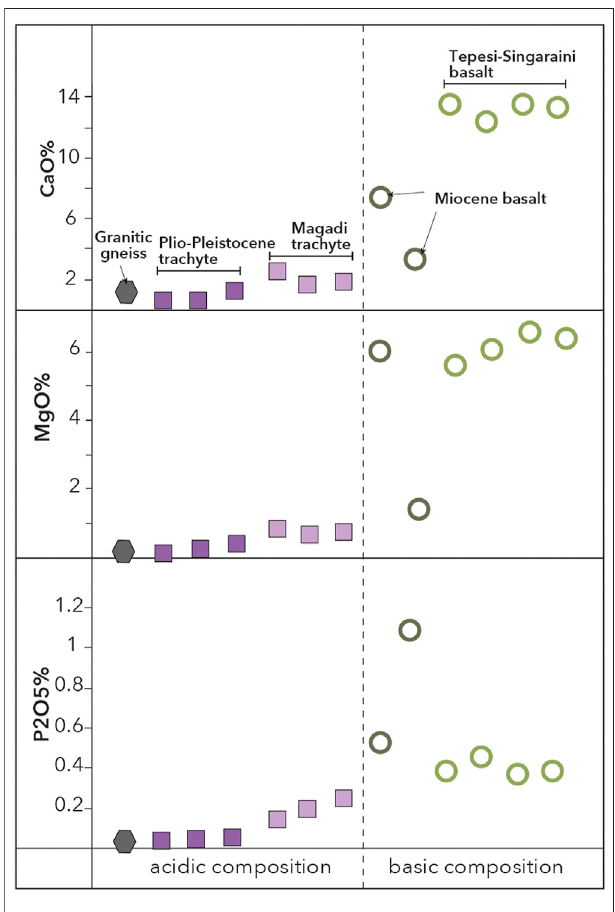
FIGURE 2 | Results of XRF whole rock analysis of the representative samples comprising basaltic, trachytic and subordinate granitic lithologies. Different lithological units are represented by varying symbols and colors. Dashed vertical line depicts separation between basic and acidic geochemical